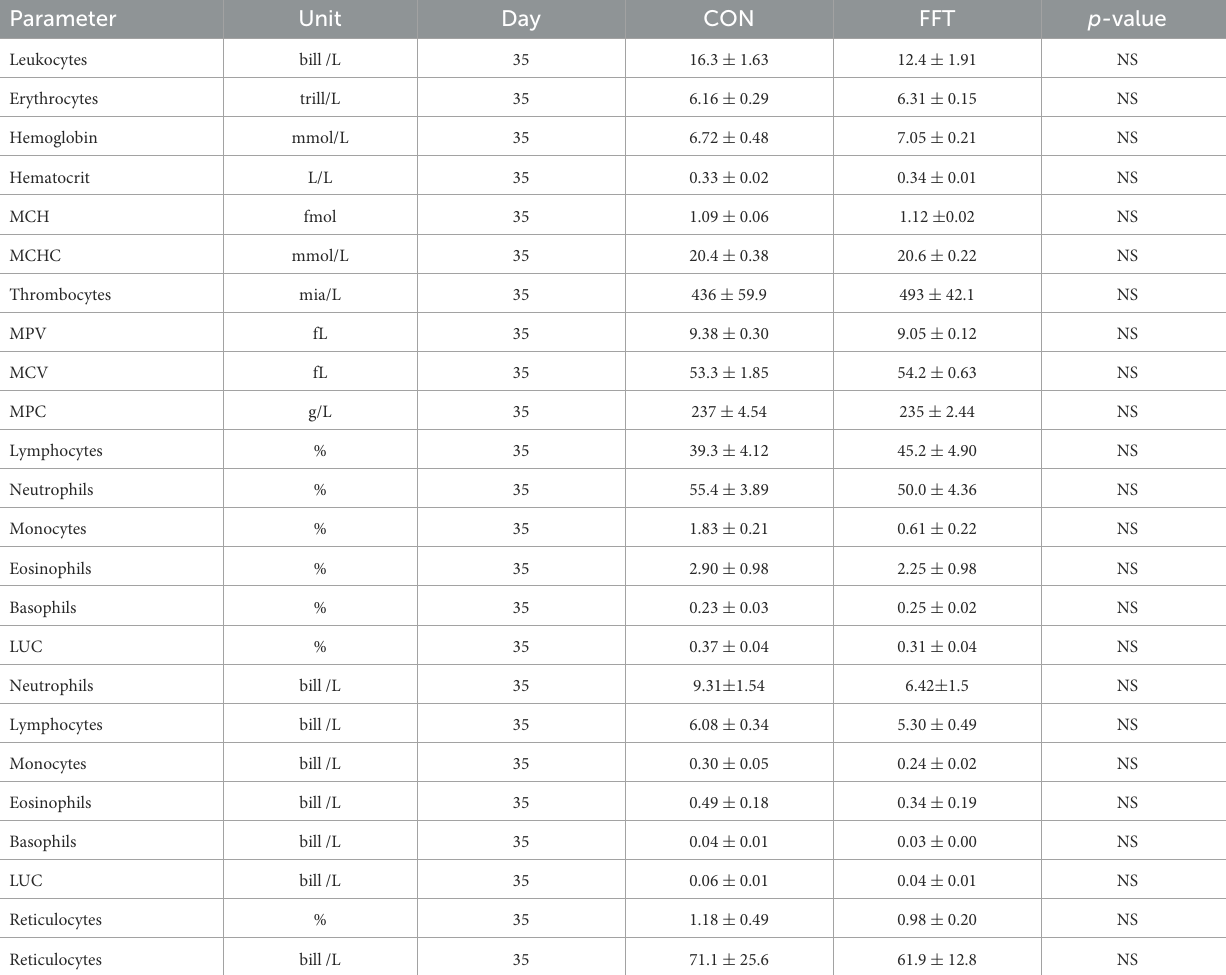
TABLE 7 Hematological parameters of piglets on day 35 ( n = CON: 6; FFT: 8). Parameter Unit Day CON FFT p- value